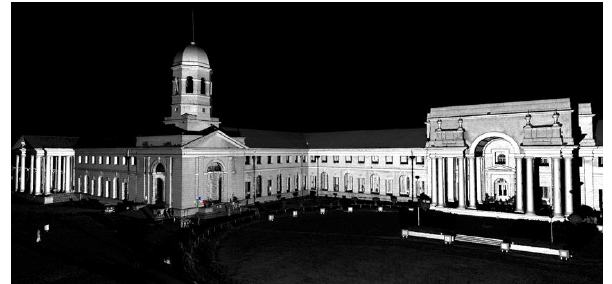
Figure 1. Forest Research Institute 3D model point